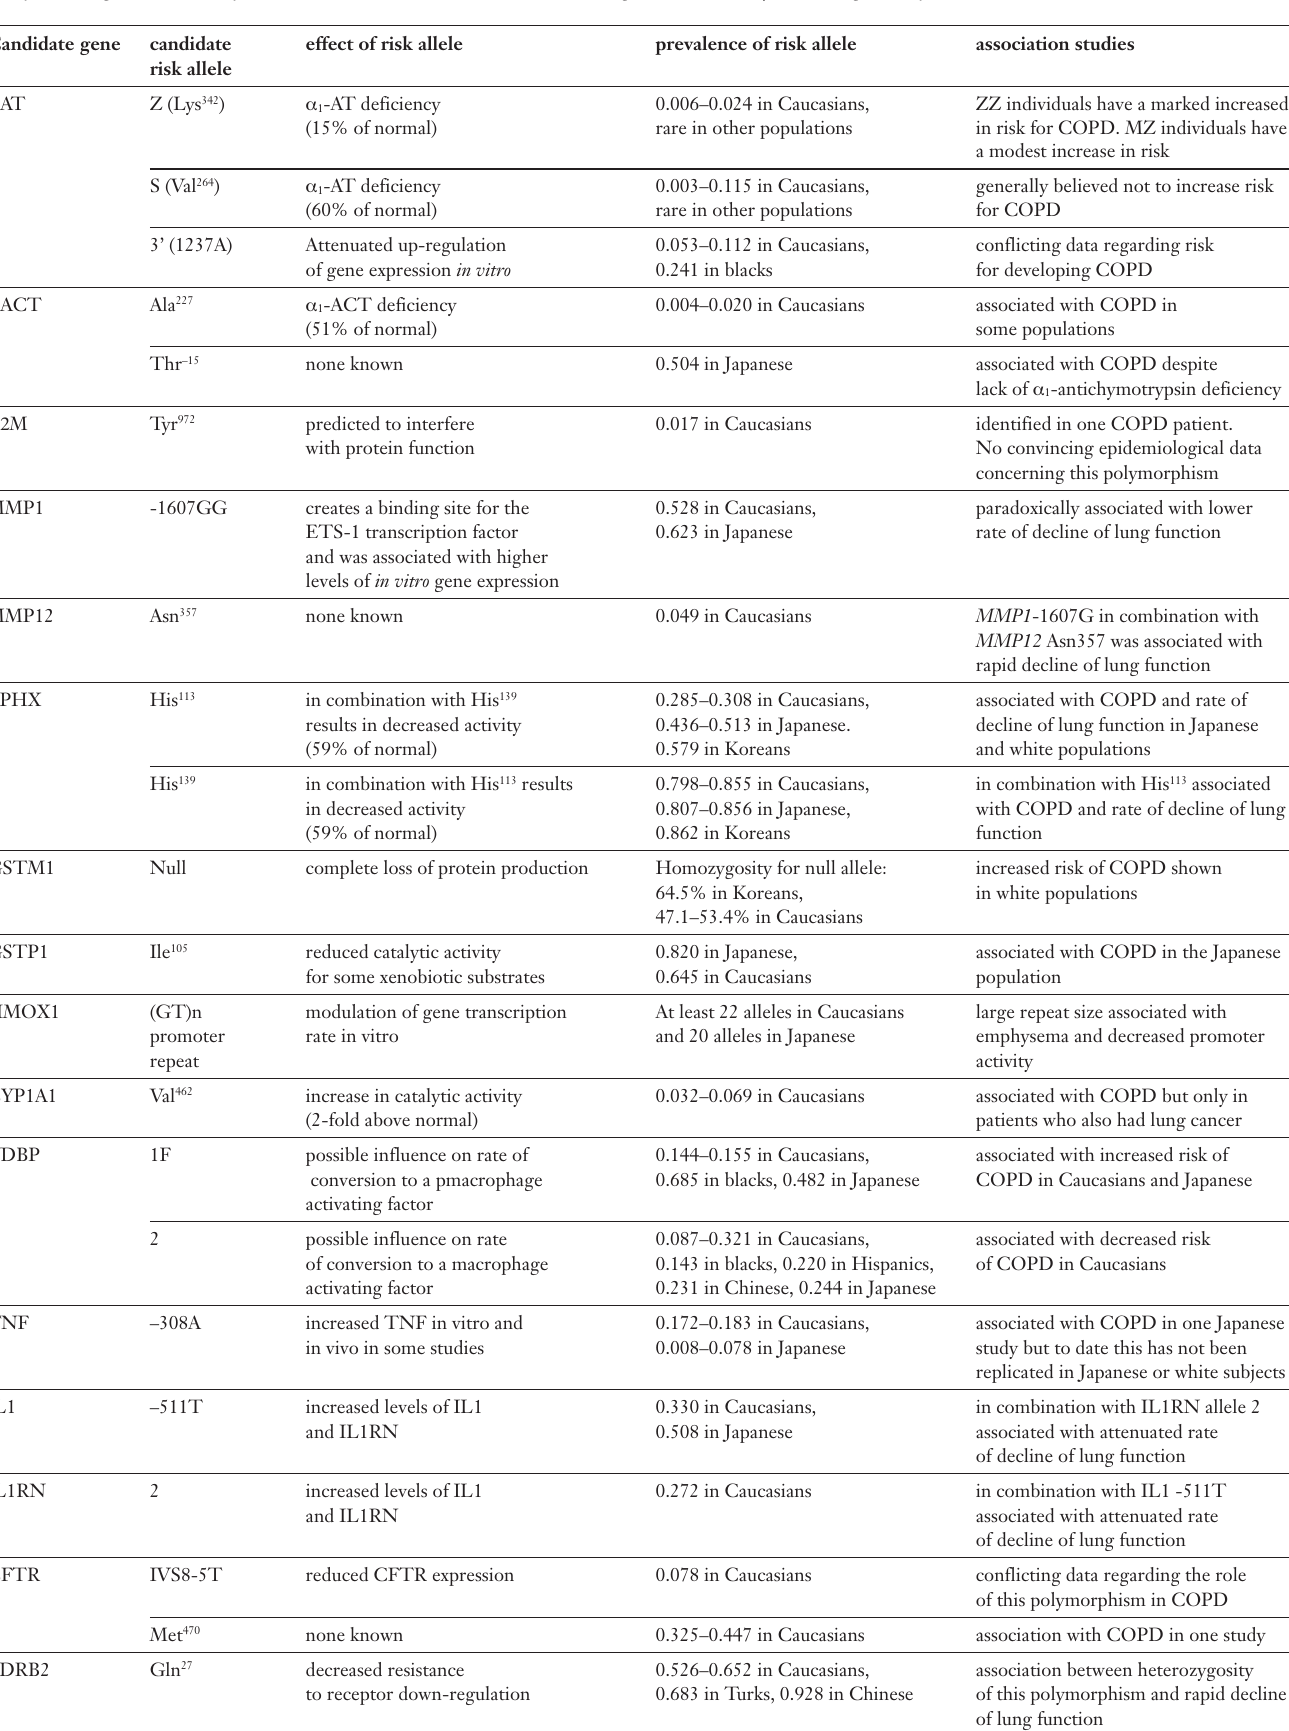
Summary of candidate genes and polymorphisms implicated in the pathogenesis of COPD. Α AT: α 1 -antitrypsin, Α ACT: α 1 -antichymotrypsin, Α 2 M: α 2 -macroglobulin, MMP: matrix metalloproteinase, EPHX1: microsomal epoxide hydrolase, GST: glutathione S-transferase, HMOX1: heme oxy- genase-1, CYP1A1: Cytochrome P4501A1, VDBP: vitamin D binding protein, TNF: tumour necrosis factor- α , IL1: interleukin-1, IL1RN: interleukin-1 receptor antagonist, CFTR: cystic fibrosis transmembrane conductance regulator, ADRB2: β 2 -adrenergic